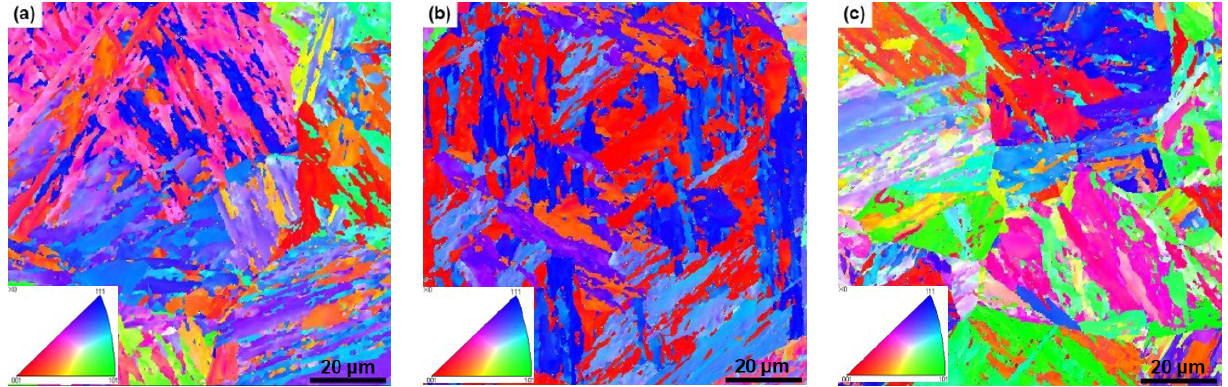
Figure 12. Phases distribution and BC values mixed with Gaussian fitted curves of samples under different treatments: ( a , b ) 1300 °C, t 8/5 = 20 s; ( c , d ) 1250 °C, t 8/5 = 20 s; ( e , f ) 1200 °C, t 8/5 = 20 s.